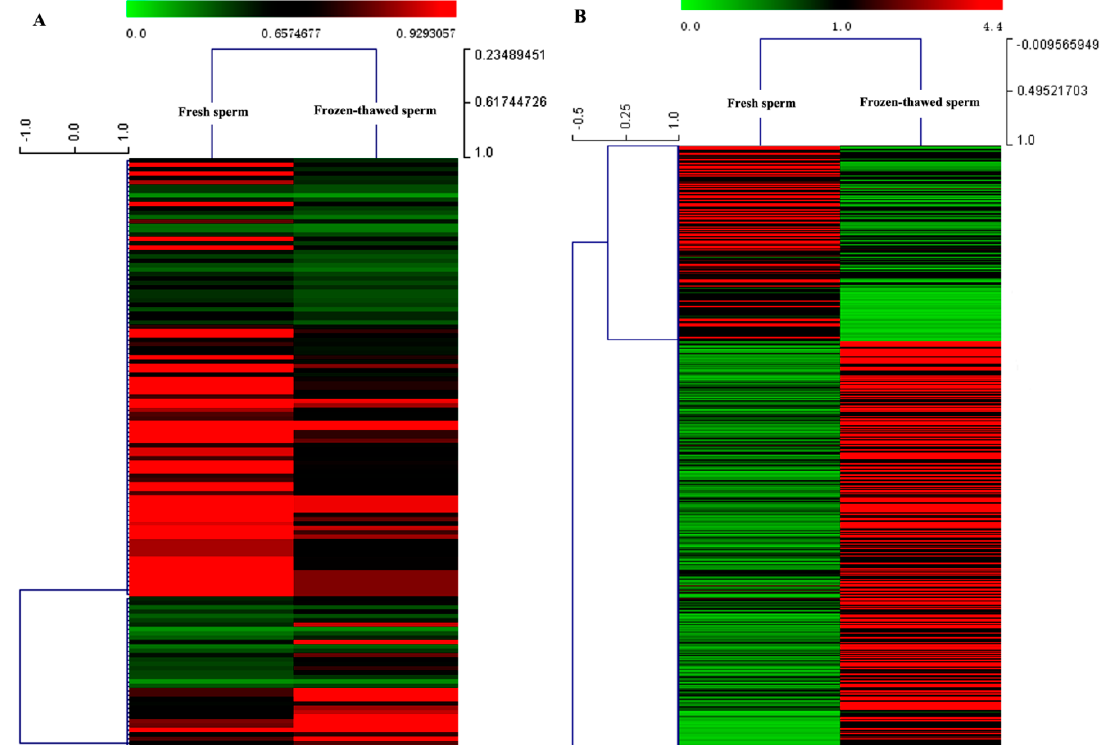
Figure 2. Hierarchical cluster analysis of significantly differentially expressed miRNAs and mRNAs in fresh and frozen ‐ thawed boar sperm. ( A ) miRNAs. The color represents the level of expression of the miRNA, log10 (TPM + 1); ( B ) mRNAs. The color represents the level of expression of the mRNA, log2 (FPKM + 1). Red and green colors denote high and low expression of miRNA or mRNA, respectively. x ‐ and y ‐ axes show Euclidean distances and Pearson ′ s correlation.